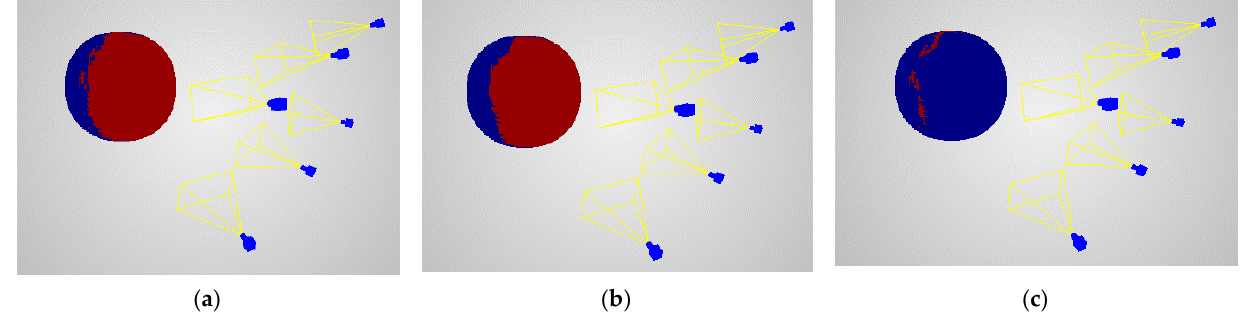
Figure 9. Reconstruction coverage on six-camera scenario with the sphere on the Z -axis at 2-m distance: ( a ) evaluations, ( b ) predictions, ( c ) differences. Red points represent areas where the sphere was reconstructed for evaluations and predictions and for differences where the evaluations differed from predictions. Blue points show otherwise. Table 2. Invalid reconstruction coverage predictions ratio for different scene